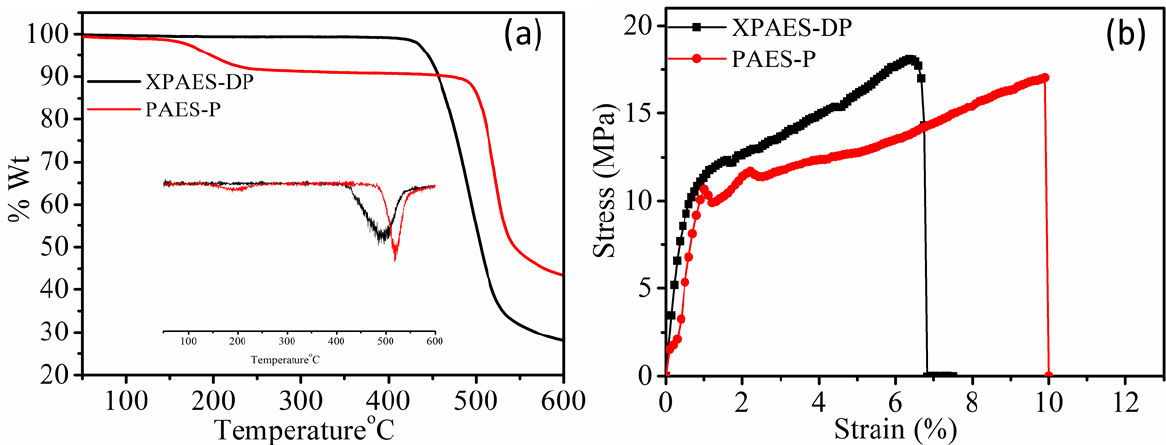
Figure 5. ( a ) Thermal degradation (dTg in inset) and ( b ) tensile stress vs. strain behavior for XPAES- DP and PAES-P membranes.